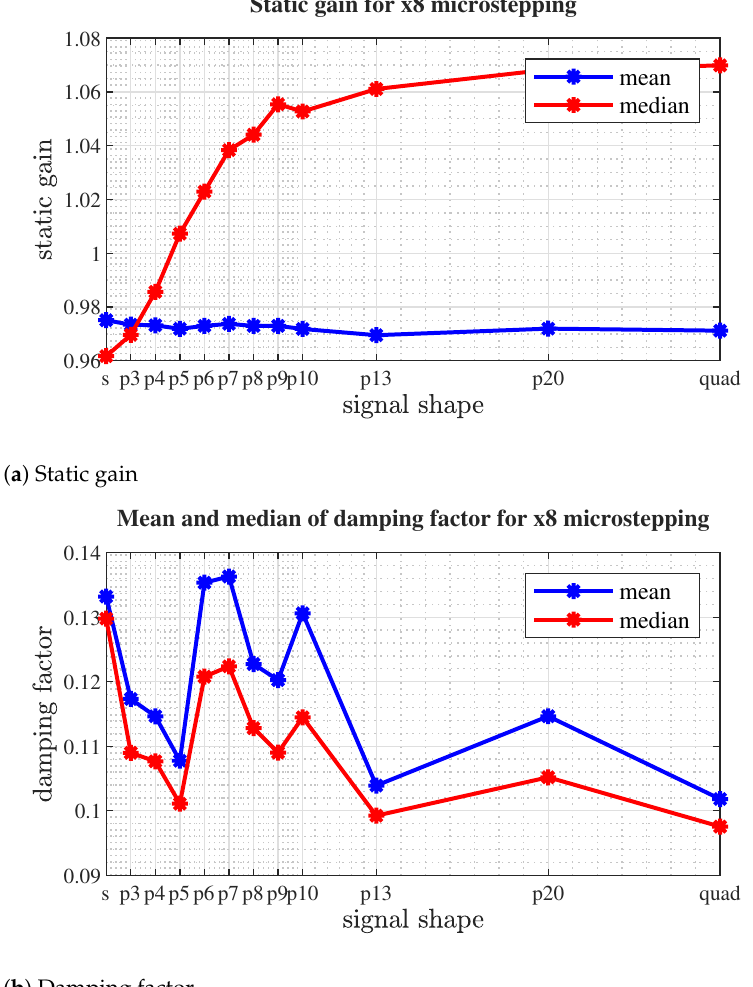
Figure 20. Medium and median values of estimated parameters for selected microstepping signals at x8 resolution. Horizontal axis is not of uniform scale, since quadrature signal corresponds with p = ∞ . Axis label s denotes sine-cosine microstepping.